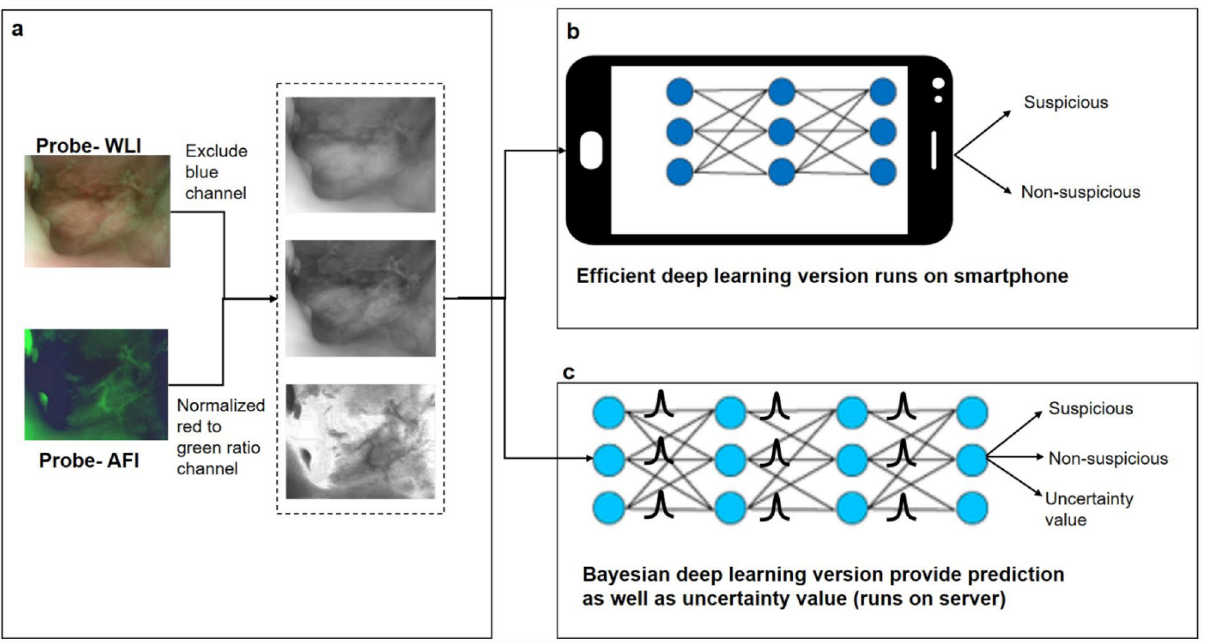
Figure 2. Pipeline of artificial intelligence-based image classification. The feature extraction of probe WLI and AFI was performed using green and red channels of WLI and the normalized ratio of AFI-red/green channels ( a ). These images were fused to feed the neural networks for real-time analysis in phones and also for cloud systems. The efficient version of Convolutional Neural Network (CNN) was built which runs on a smartphone device ( b ) classified images as suspicious or non-suspicious. Another more complex CNN based on Bayesian deep learning framework was built ( c ) for predicting uncertainty along with diagnosis in a cloud system. CNN Convolution Neural Network, WLI White Light Imaging, AFI Auto-fluorescence Imaging)